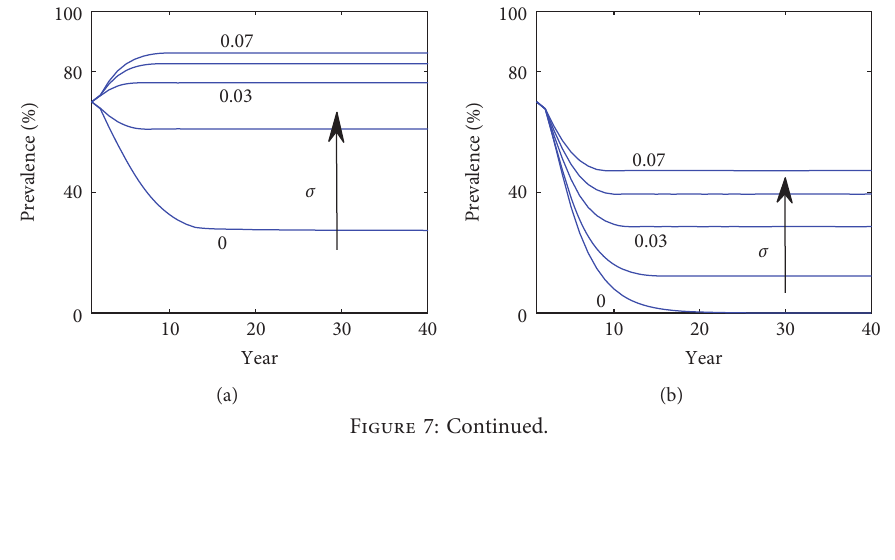
versus the recovery rate η . (b) R t versus 0 0 versus the vertical infection rate of vaccinated infected cows ρ v 2 0